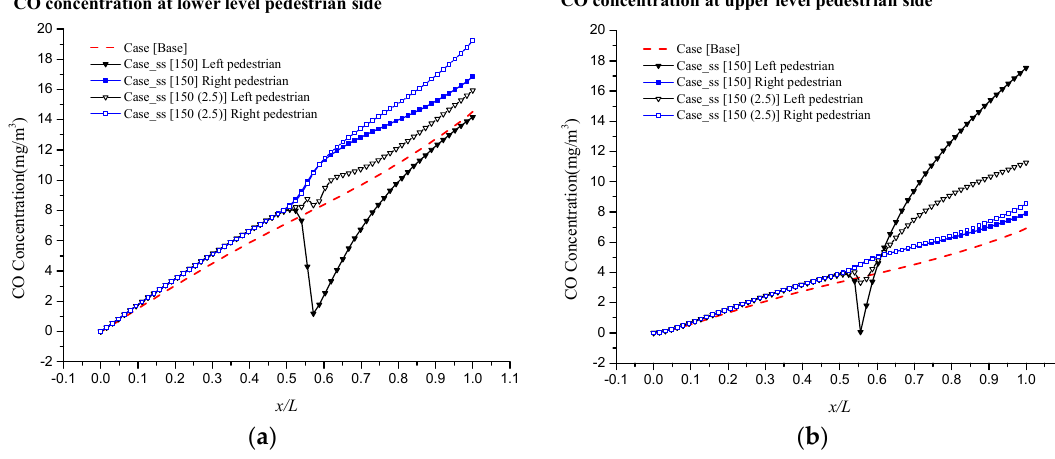
Figure 12. CO concentration in Case_ss [150] and Case_ss [150 (2.5)] at: ( a ) Lower level pedestrian side and ( b ) upper level pedestrian side.